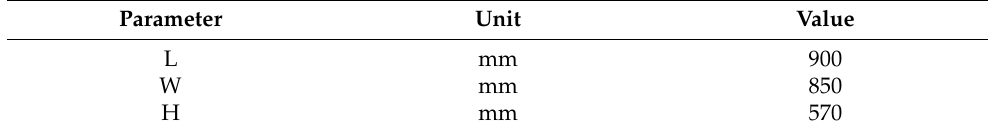
Table 1. Dimensions of the paddle mixer as shown in Figure